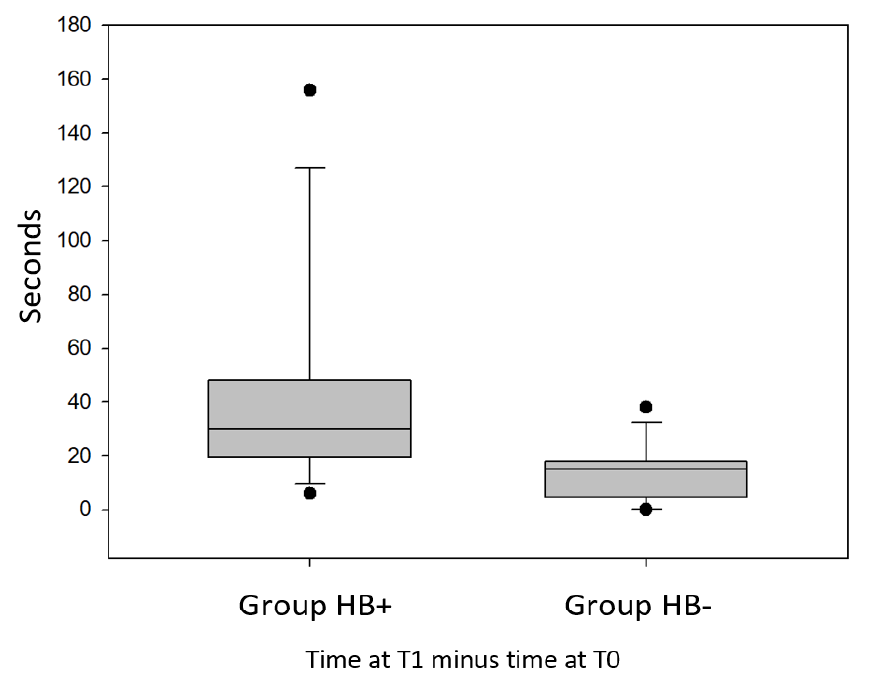
Figure 4. Di ff erence in recorded times between T1 and T0 of the Hb + group compared with the same Figure 4. Difference in recorded times between T1 and T0 of the Hb+ group compared with the same di ff erence measured in the Hb- group with the stork balance stand test (SBST). J. Funct. Morphol. Kinesiol. 2020 , 5 , x FOR PEER REVIEW difference measured in the Hb- group with the stork balance stand test (SBST).